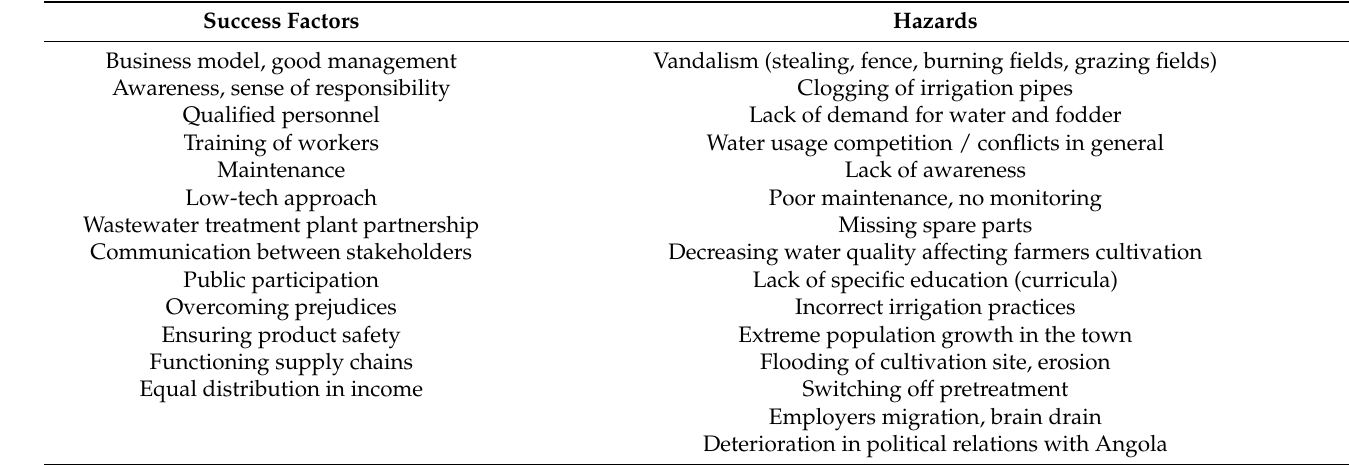
Table 1. Success factors and hazards for sustainable operation of the water reuse